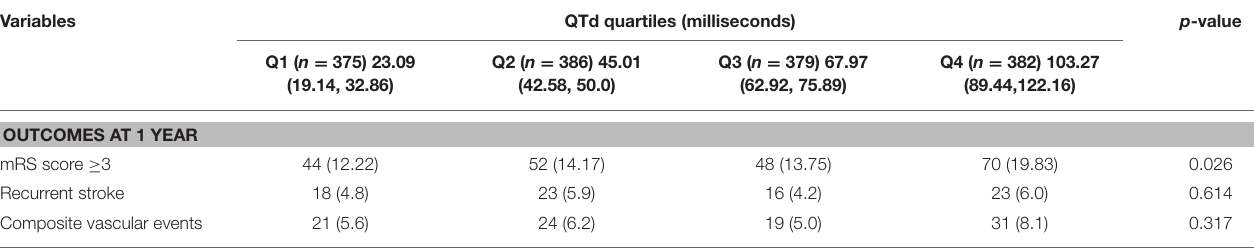
TABLE 2 | Primary and secondary outcomes according to QTd quartiles.